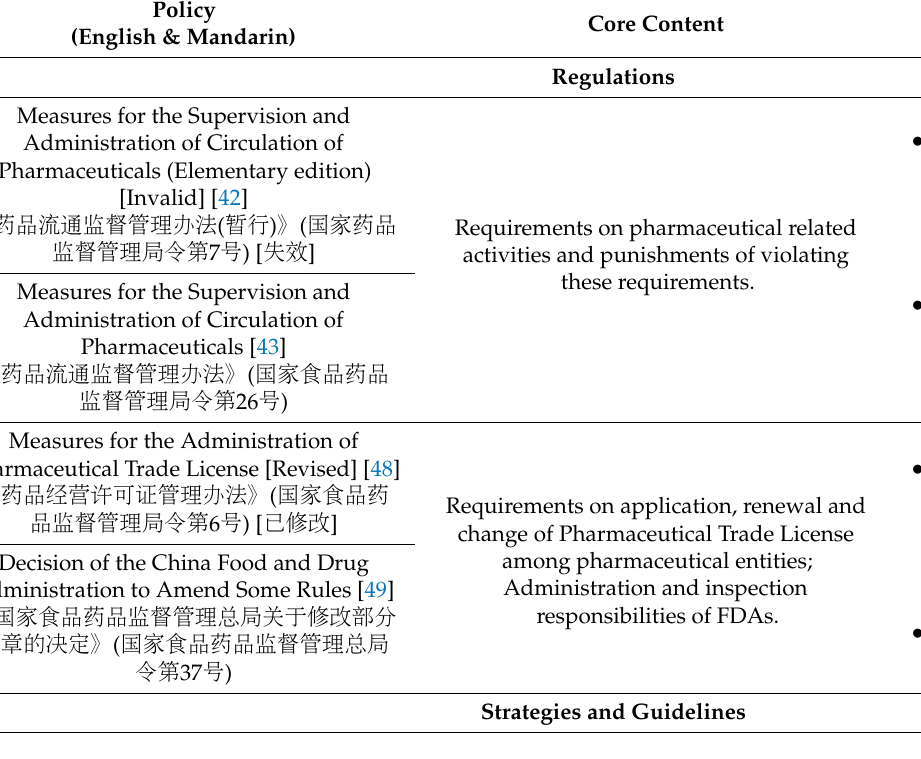
Key Points Related to Antibiotic Sales in Retail